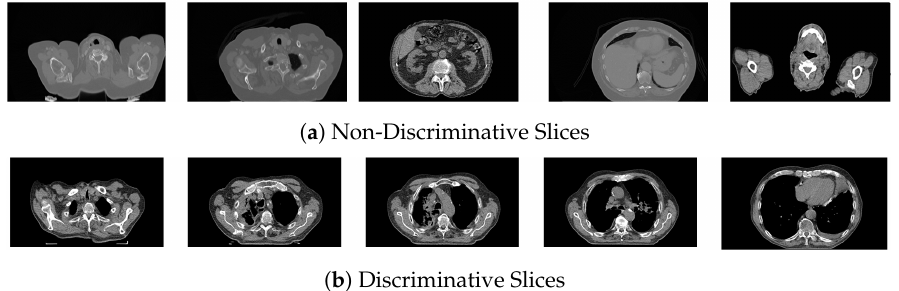
Figure 4. Various exemplars of slices (views) from different positions of different CT